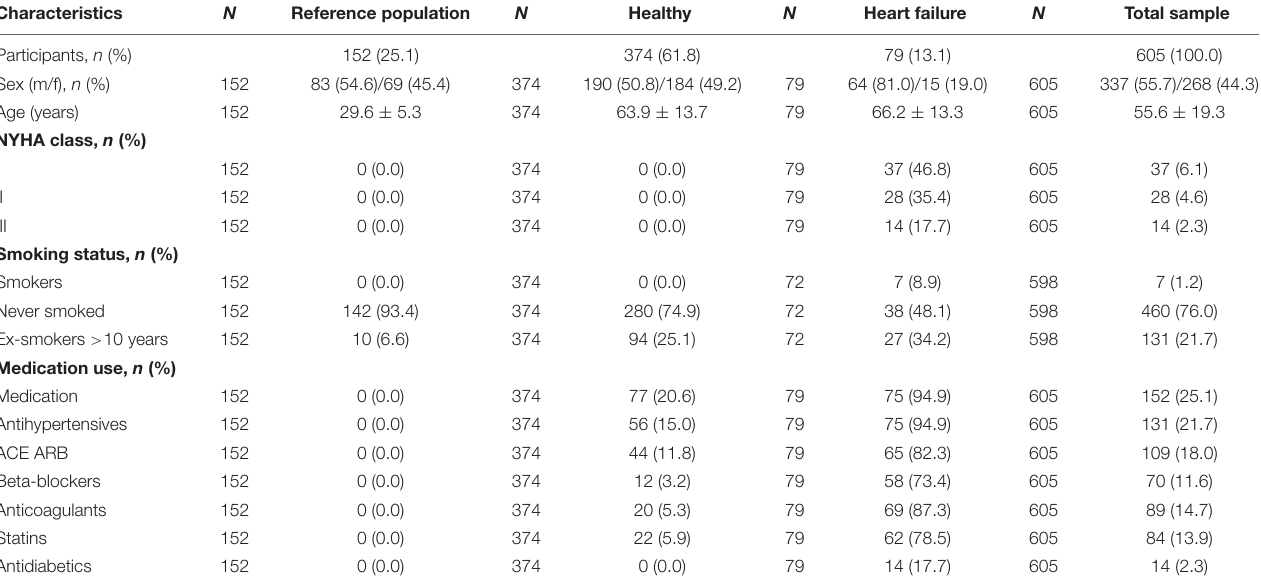
TABLE 1 | Descriptive characteristics of the study population separated into Reference Population (healthy participants aged ≤ 39 years), Healthy (healthy participants aged ≥ 40 years), and Heart Failure (patients with heart failure). Data are presented as mean ± standard deviation if not stated otherwise.